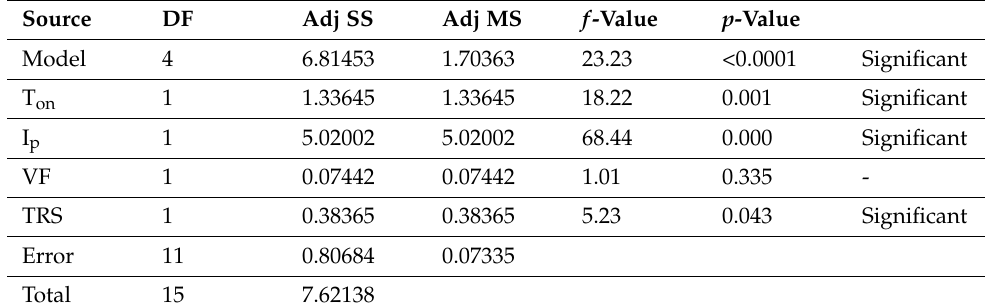
Table 7. The ANOVA for the MRR.